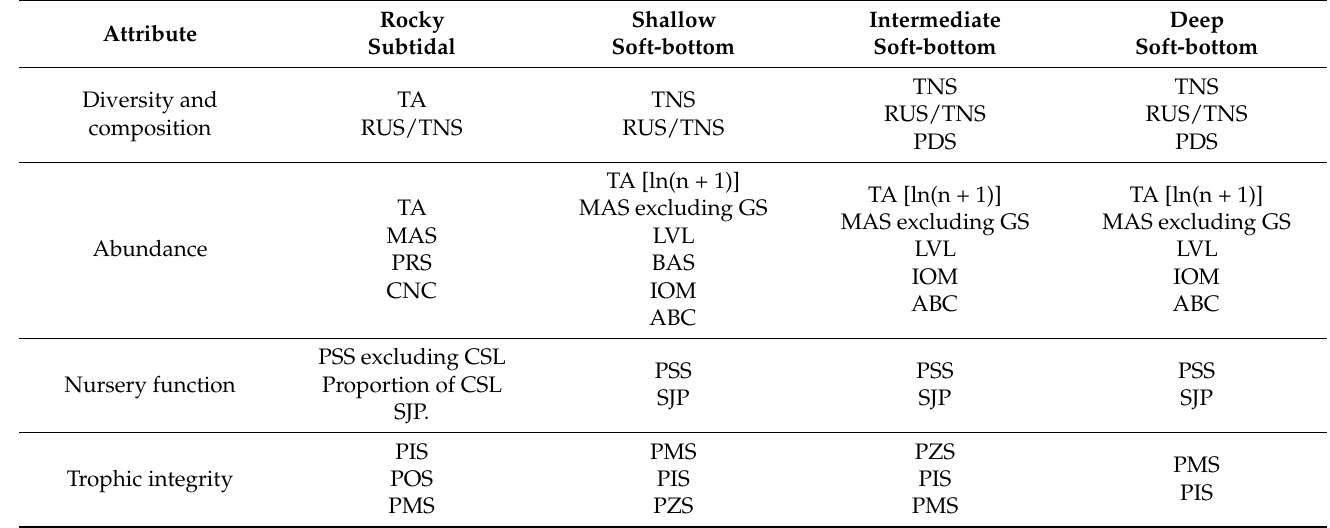
Table 4. Selected metrics for the MFCI divided by the correspondent substrate typologies; mod- ified from [69]. TNS = total number of species; RUS = number of rare or uncommon species; PDS = pelagic/demersal ratio (in number of species); TA = total abundance; MAS = number of species that make up 90% of the abundance; PRS = proportion of resident species; CNC = commercial/non- commercial ratio (in proportion of species); GS = gregarious species; LVL = proportion of low and very low resilience species; BAS = proportion of benthic-associated species; IOM = propor- tion of individuals over maturity size; ABC = ABC curves; PSS = proportion of spawning species; CSL = cryptic, Symphodus sp. and Labrus sp. Species; SJP = number of species with juveniles present or proportion of juveniles; PIS = proportion of invertivore species; POS = proportion of omnivore species; PMS = proportion of piscivore and macrocarnivore species; PZS = proportion of zooplank- tivorous